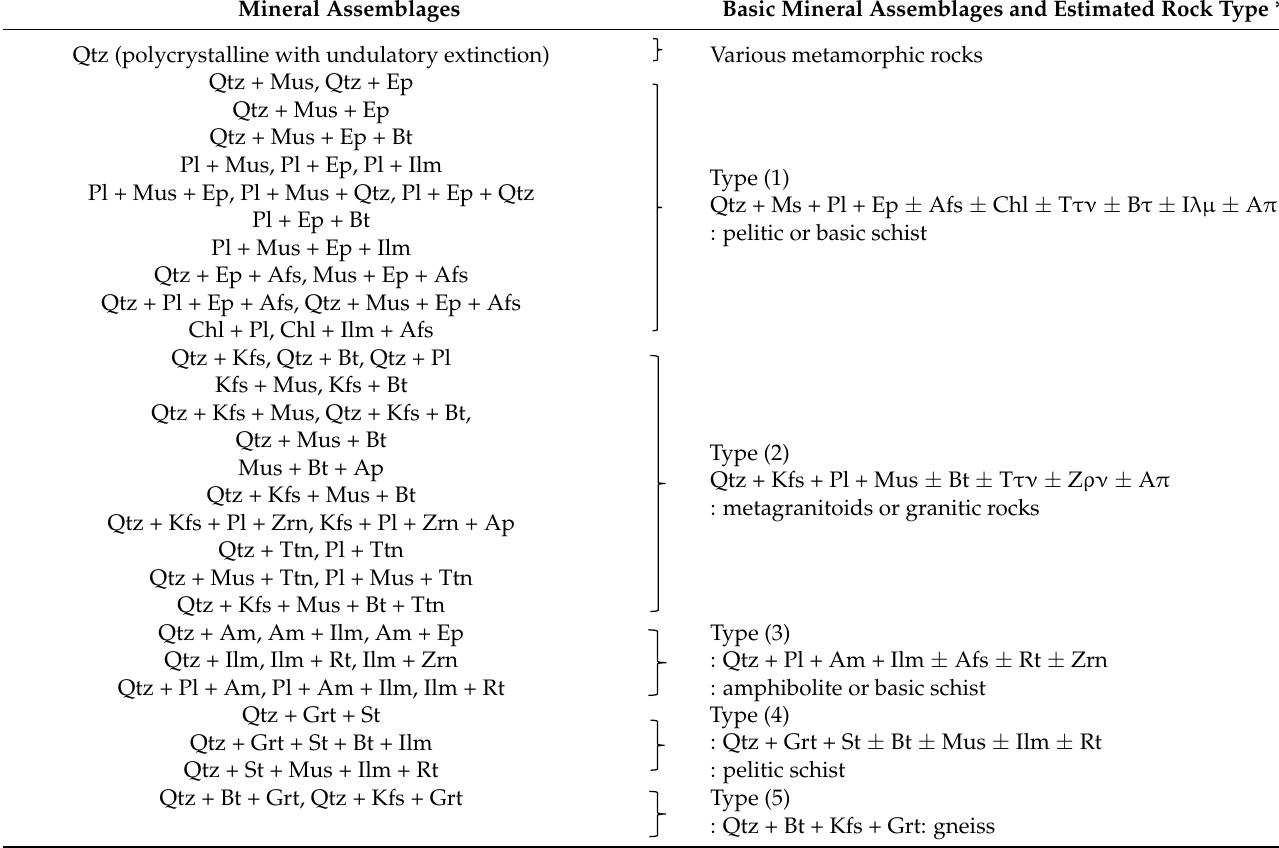
Table 3. Mineral assemblages observed in rock fragments within pottery and the estimated rock type. Abbreviations: Afs—alkali feldspar; Am—amphibole; Ap—apatite; Bt—biotite; Chl—chlorite; Ep—epidote; Grt—garnet; Ilm—ilmenite; Kfs—potassium feldspar (or microcline); Mus—muscovite; Pl—plagioclase; Qtz—quartz; Rt—rutile; St—staurolite; Ttn—titan- ite; Zrn—zircon. * Basic mineral assemblages were estimated based on combinations of the mineral assemblages. Rock types were estimated based on the basic mineral assemblages and textures observed in the assemblages.